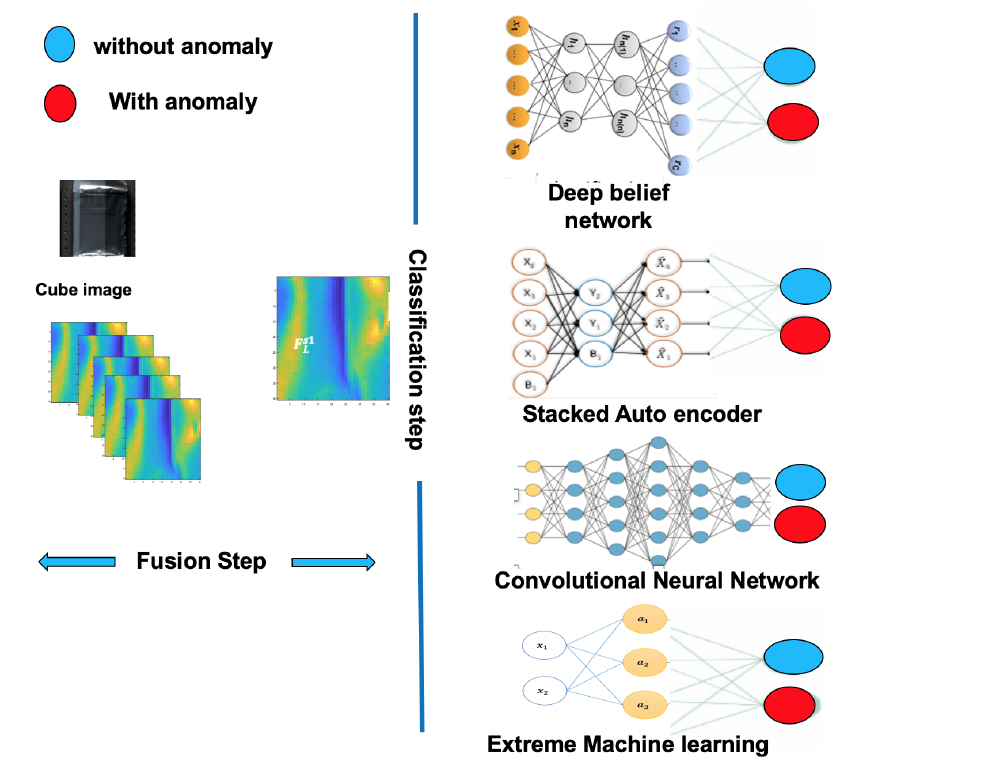
Figure 1. General framework of the food tray contamination detection based deep learning methods: first, data fusion on hyperspectral data; second, deep learning algorithm